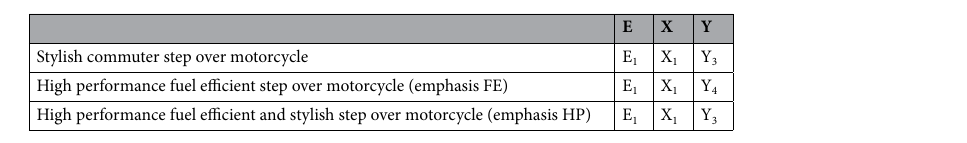
Table 6. Super-Architecture of New